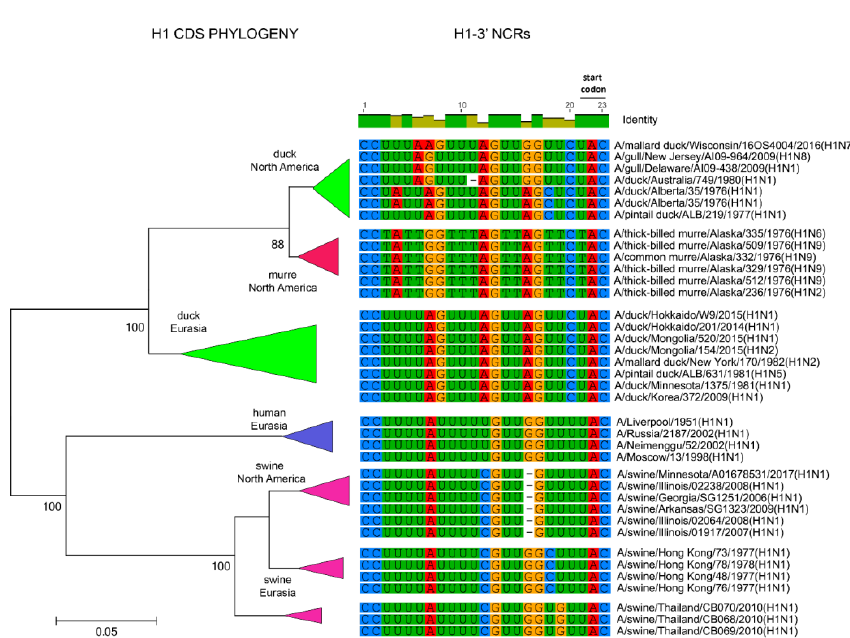
Figure 6. Relationships among H1 3 ′ NCR and CDS regions for viruses from different host species and geographic locations. Alignments of the 3 ′ NCRs, shown corresponding to the genomic RNAs, from the viruses used in the analyses are next to the CDS-based neighbor-joining tree for these viruses.